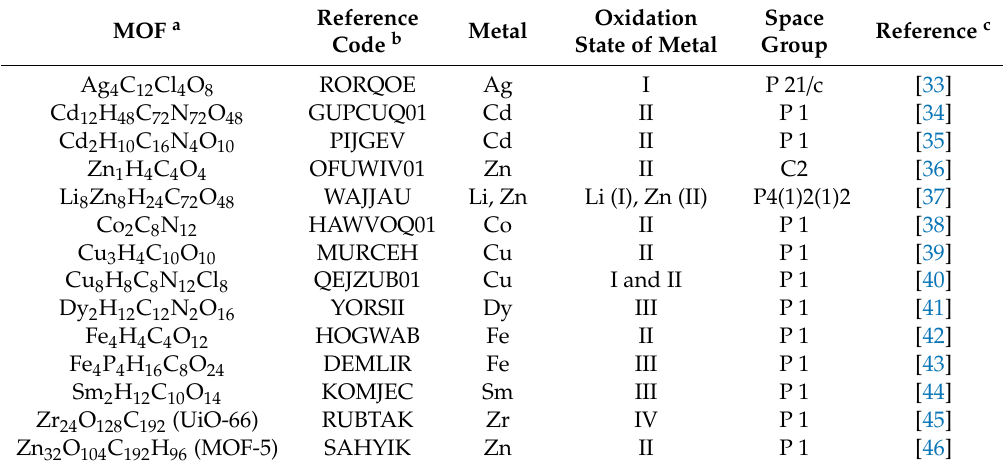
Table 1. List of metal–organic frameworks (MOFs) studied here along with their reference codes, metal centers, oxidation states, space groups, and experimental